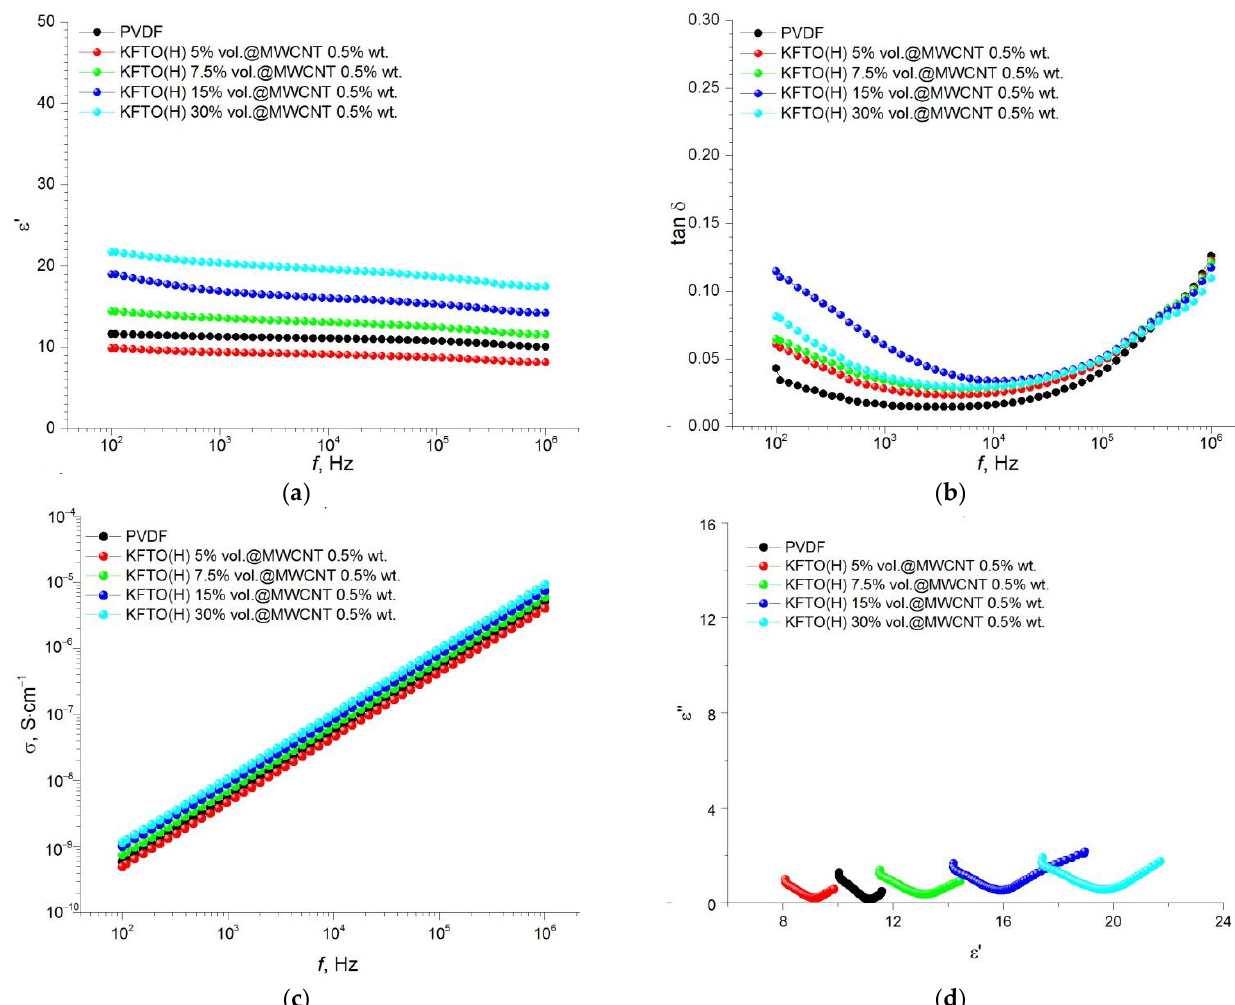
Figure 8. Frequency dependence of ( a ) permittivity, ( b ) dielectric loss tangent, ( c ) conductivity and ( d ) Cole –Cole plot (ε ꞌ –ε ꞌꞌ ) for PVDF-based composites with different volume fractions of KFTO(H) with MWCNT additive of 0.5 wt.%.